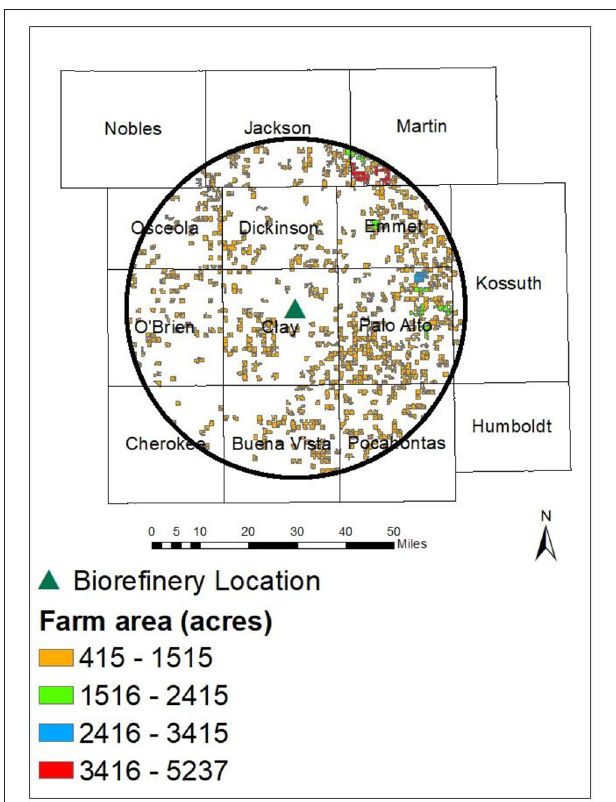
FIGURE 4 | Biorefinery location, farm locations and supply area for the case study.